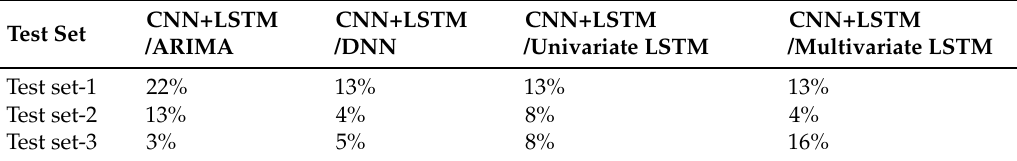
Table 10. The decrease percentage in RMSE of the proposed model compared to other models in each test set of